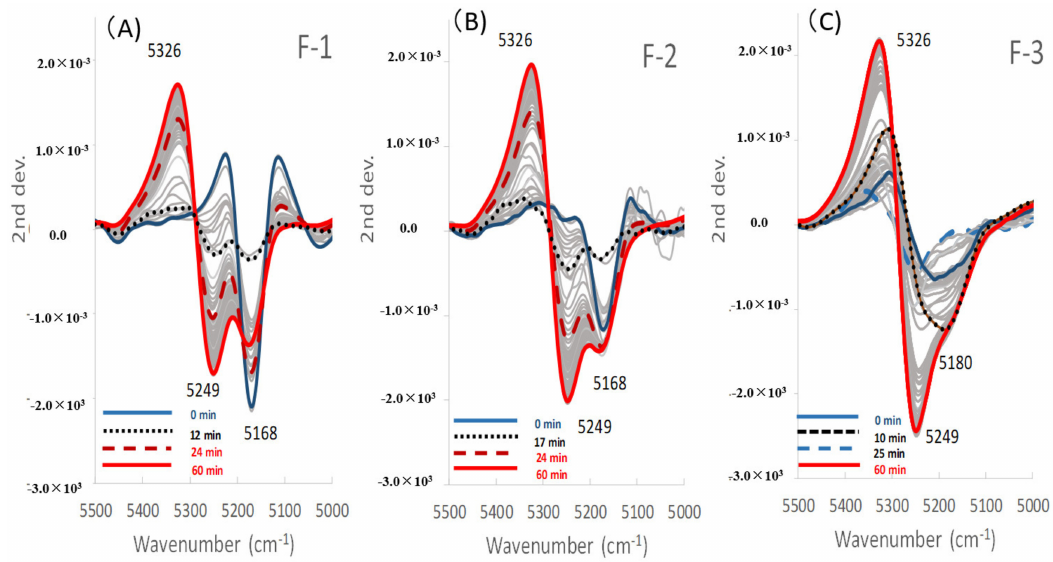
Figure 7. Second derivative near-infrared spectra for the band 5000–5500 cm − 1 of the model powder formulations during the high-speed shear wet granulation processes. ( A ) The lactose sample, ( B ) mixture sample, and ( C ) starch